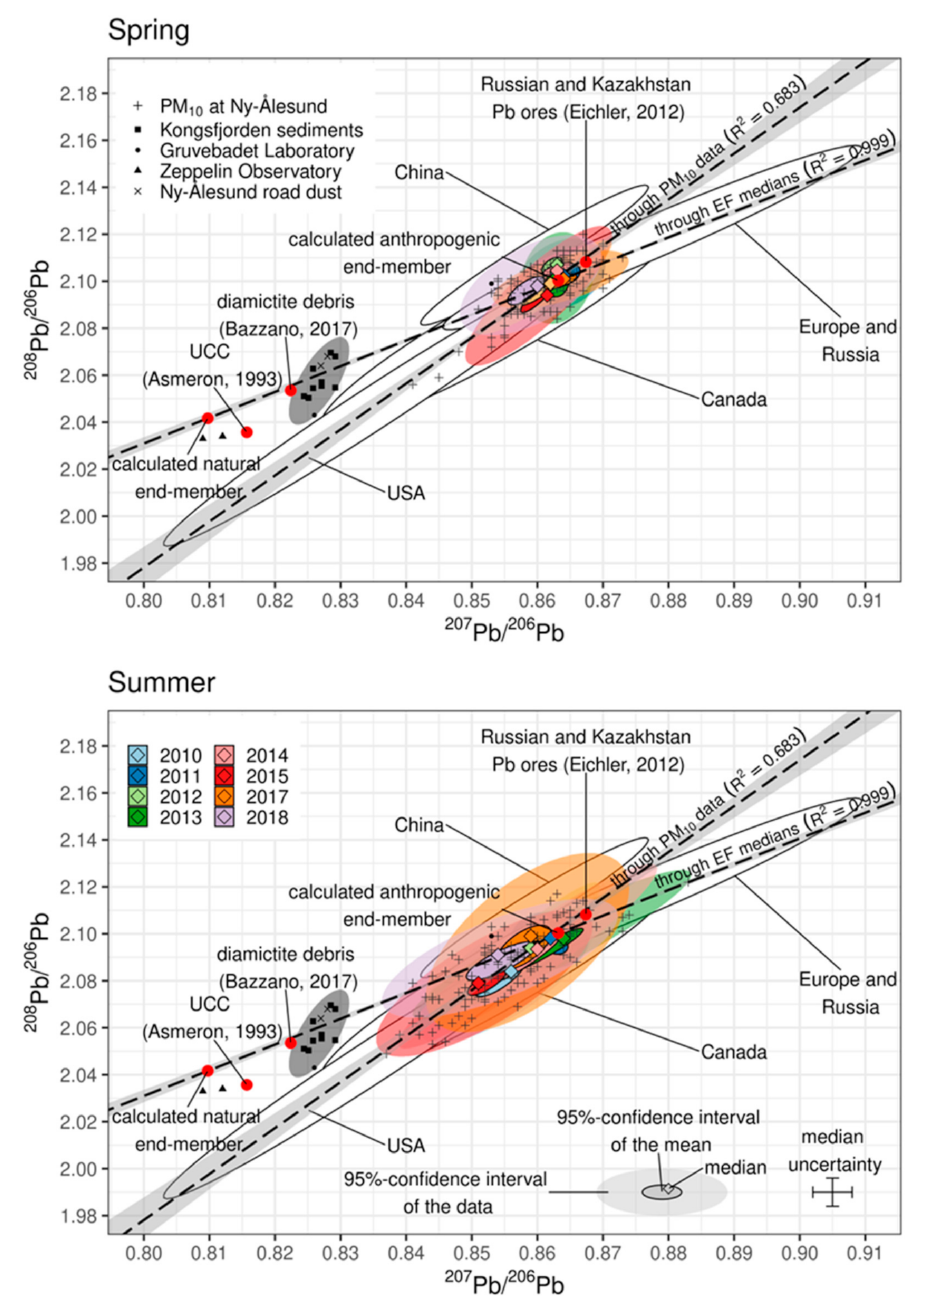
Figure 4. Annual median Pb isotope ratio values for PM 10 samples collected at Ny-Ålesund from 2010 to 2018 during spring and summer, represented in three-isotope plots. Black ellipses rep- resent the joint-distribution (95% confidence level) of literature data. Canada and USA: [22,38], Europe: [21,22,39] Russia: [21,22], China: